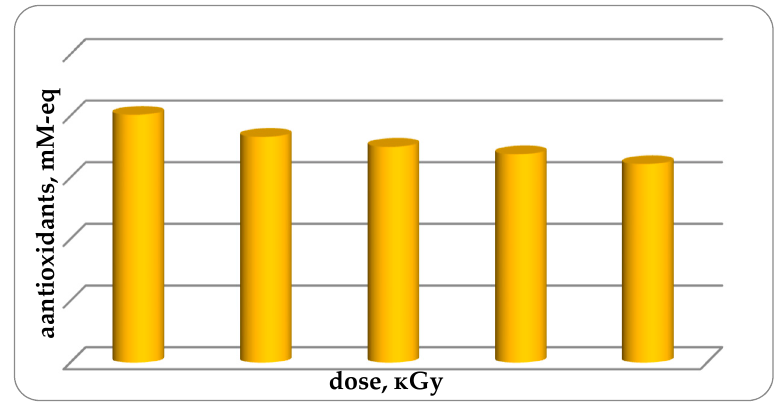
Figure 6. AOA fish samples ( p ≤ 0.01) .